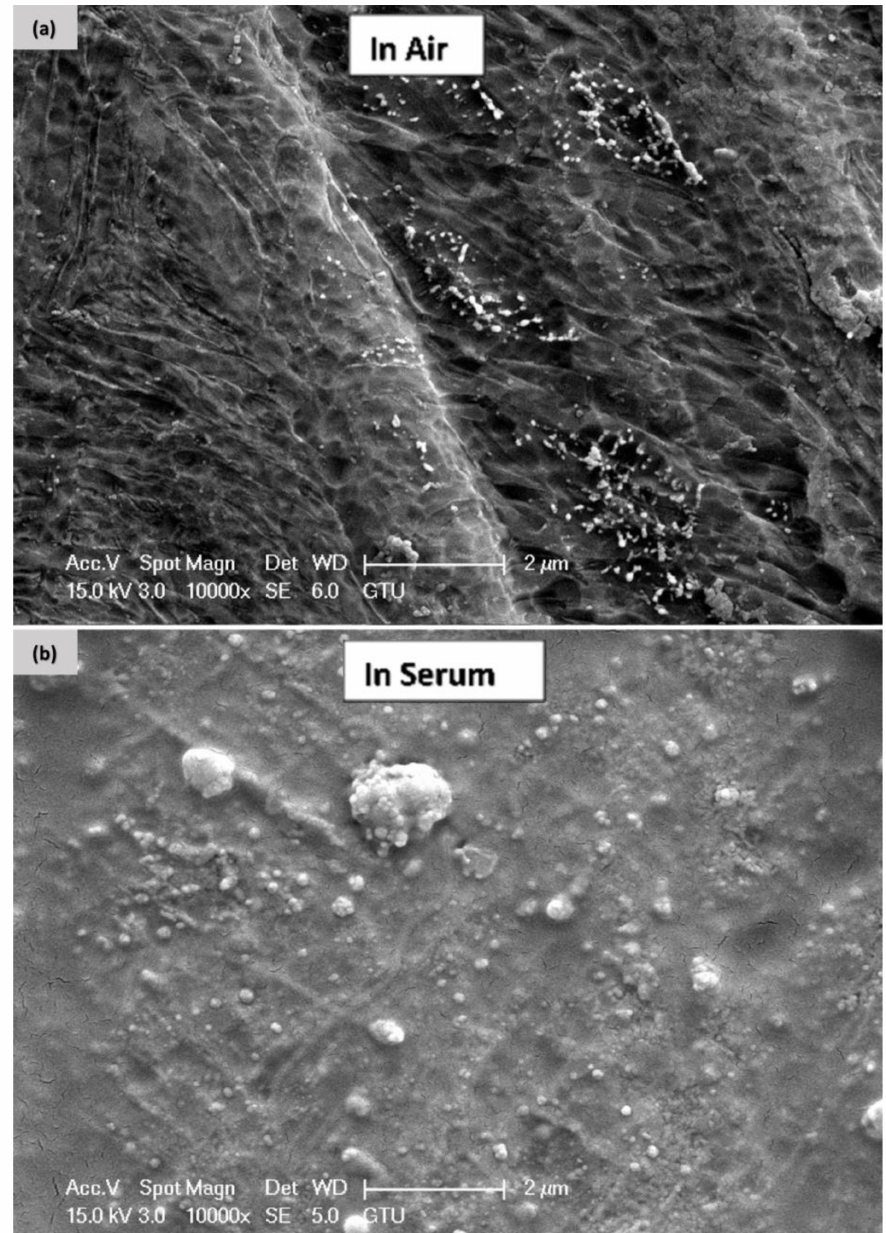
Figure 4. SEM micrographs of Ti6Al4V welded in air ( a ) and in serum ( b ). In the SEM micrographs (Figure 4a), the samples resemble a sea wave since argon is used as a shielding gas in the welding. The micro image in Figure 4b indicates that elements such as sodium, potassium, etc., were separated in the serum medium. The segment that resembles a round stone represents oxygen, see Figure 4b. Figure 6 represents the microstructure of BM at room temperature. BM mainly consists of equiaxed α phase which appears light in color and an inter-granular phase which appears dark in